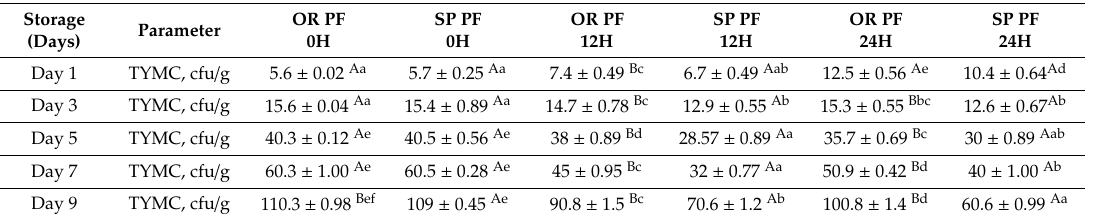
Table 5. Total count of yeasts and molds (TYMC) evolution (cfu / g) during storage days of the final products